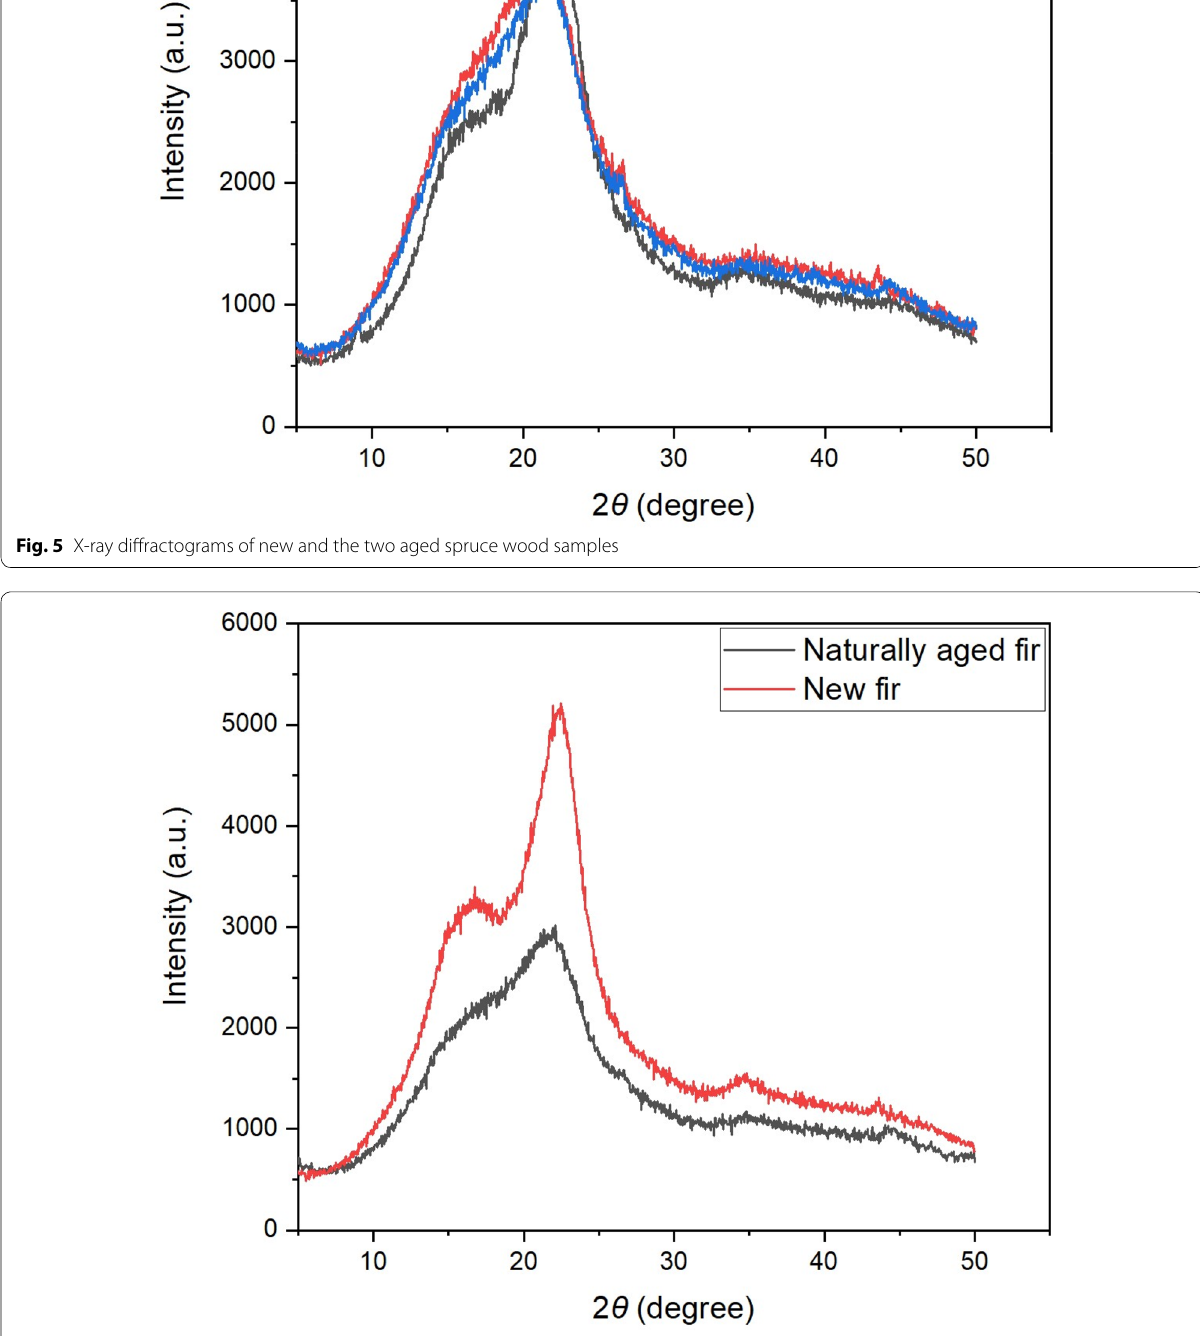
Fig. 6 X-ray diffractograms of new and aged fir